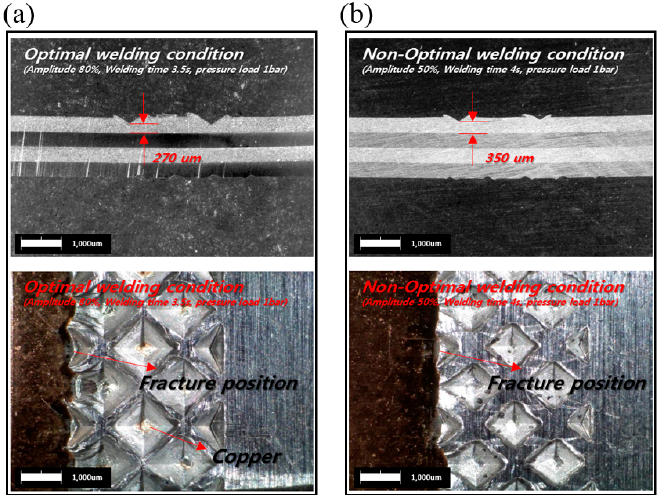
Figure 16. Comparison of cross section for aluminum indentation thickness between optimal welding conditions and non-optimal welding conditions. ( a ) Optimal welding conditions; ( b ) non-optimal welding conditions.